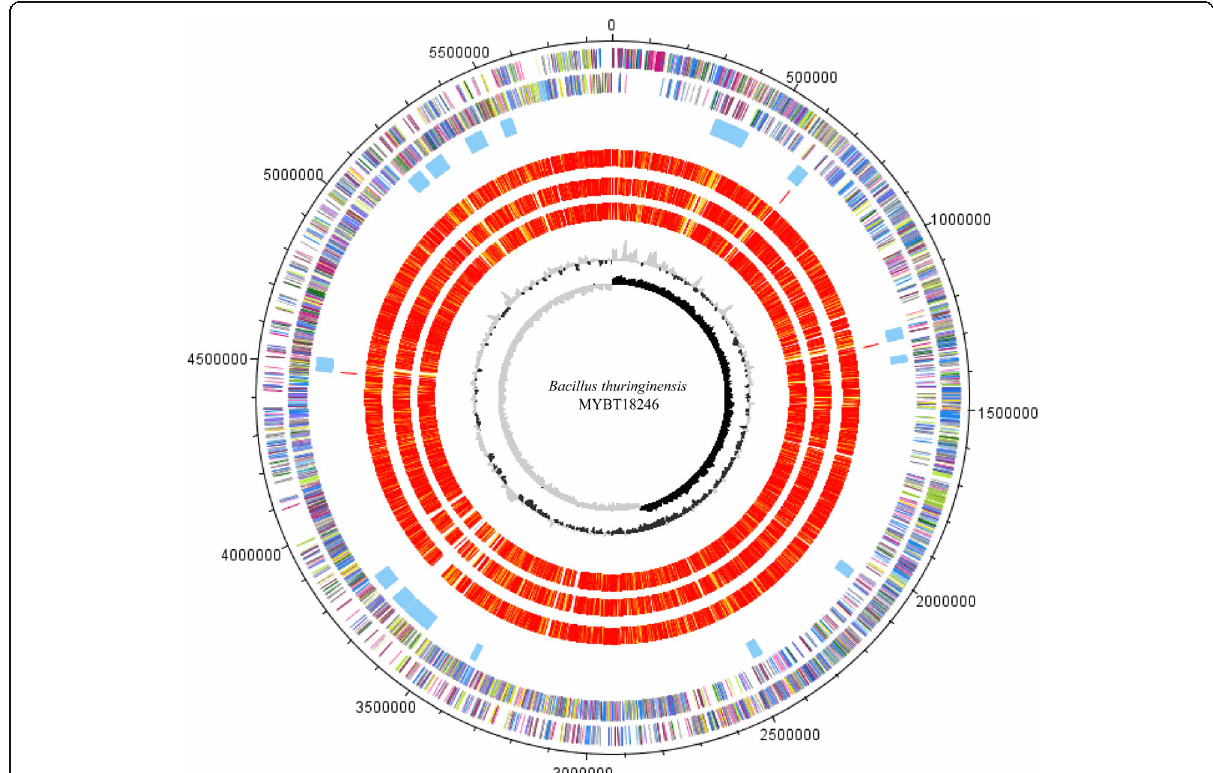
Fig. 3 Circular visualization of the genome comparison of B. thuringiensis MYBT18246 with 3 other sequenced B. thuringiensis strains. The tracks from the outside represent: (track 1 – 2) Genes encoded by the leading and lagging strand of B. thuringiensis MYBT18246 marked in COG colors [93]; (track 3) putative prophage regions, identified with PHAST in blue [76], (track 4) identified cry toxin genes in red; (track 5 – 7) orthologs for the genomes of B. thuringiensis YBT-1518 (CP005935.1), B. thuringiensis CT-43 (CP001907.1), B. thuringiensis Bt407 (CP003889.1) illustrated in red to light yellow, singletons in grey (grey: <1e − 20 ; light yellow: 1e − 21 – 1e − 50 ; gold: 1e − 51 – 1e − 90 ; light orange: 1e − 91 – 1e − 100 ; orange: 1e − 101 – 1e − 120 ; red: >1e − 121 (track 7) % GC plot (track 8), GC skew [(GC)/(G + C)]. Visualization was done with DNAPlotter